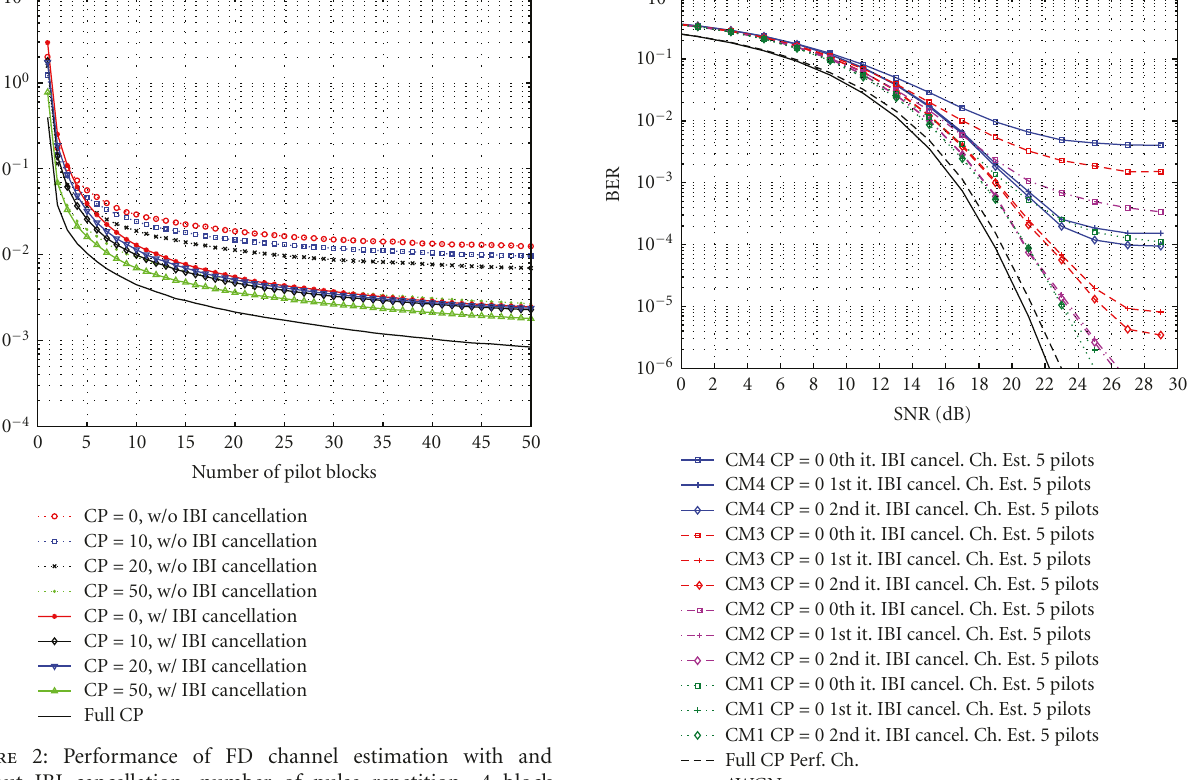
ff erent channel models, for CP = 0 and channel estimation with 5 pilot